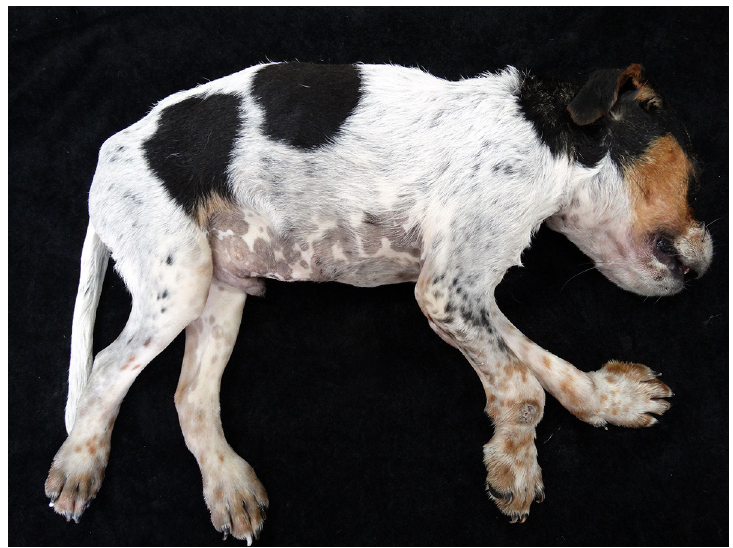
Figura 1. Observa-se acentuada deformidade esquelética, na qual os membros se encontram encurvados, principalmente os membros torácicos.